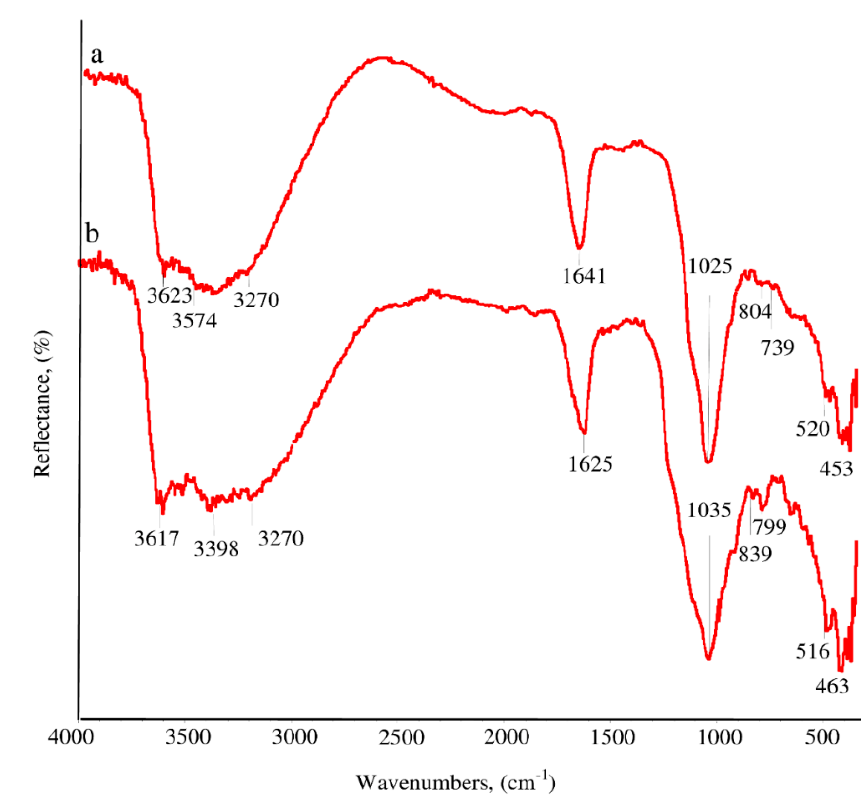
Figure 8. Fourier transform infrared spectra of raw ( a ) and acid-treated saponite ( b ).